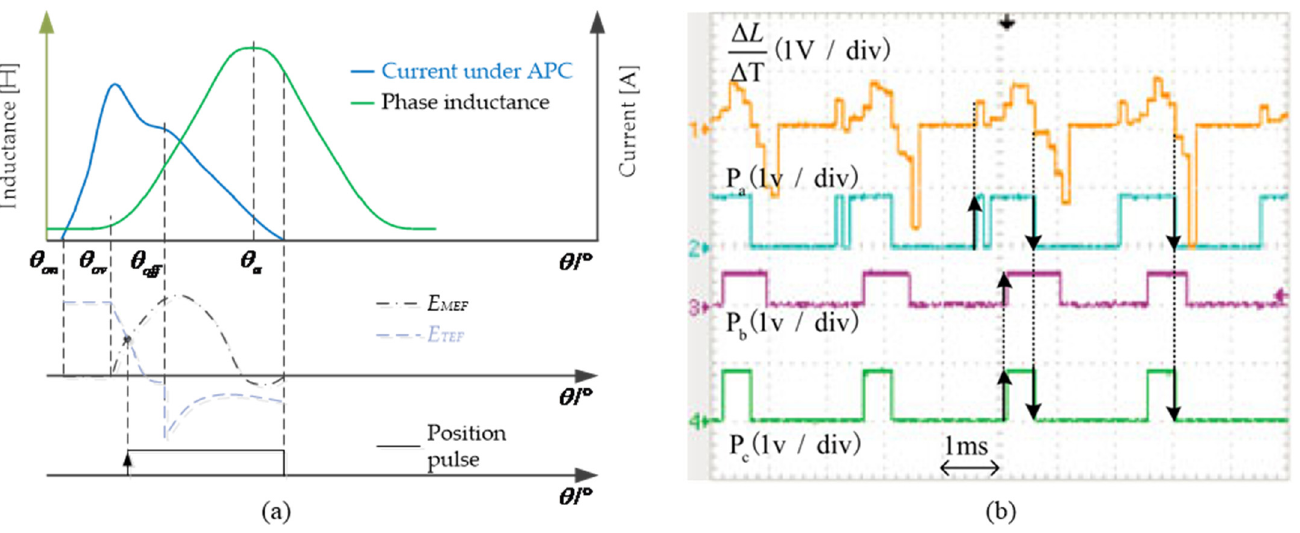
Figure 12. Principle of the crossing point of E MEF and E TEF ( a ) Principle ( b ) Experiment [148].